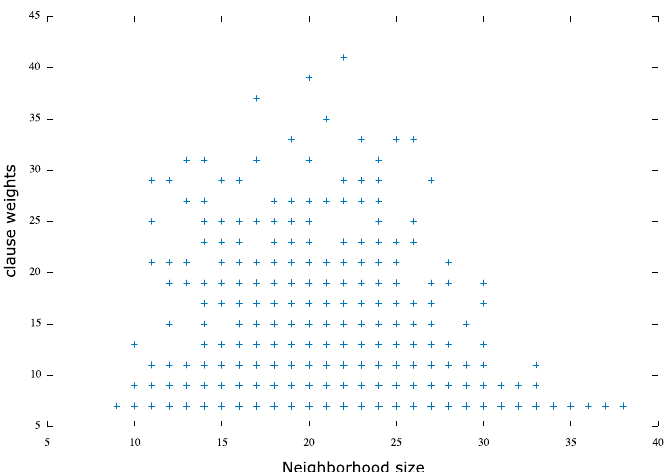
Figure 4. The figure illustrates the most weighted clauses and their corresponding neighborhood size for the uuf problem set (30 instances), where the overall average of the neighborhood size is ≈